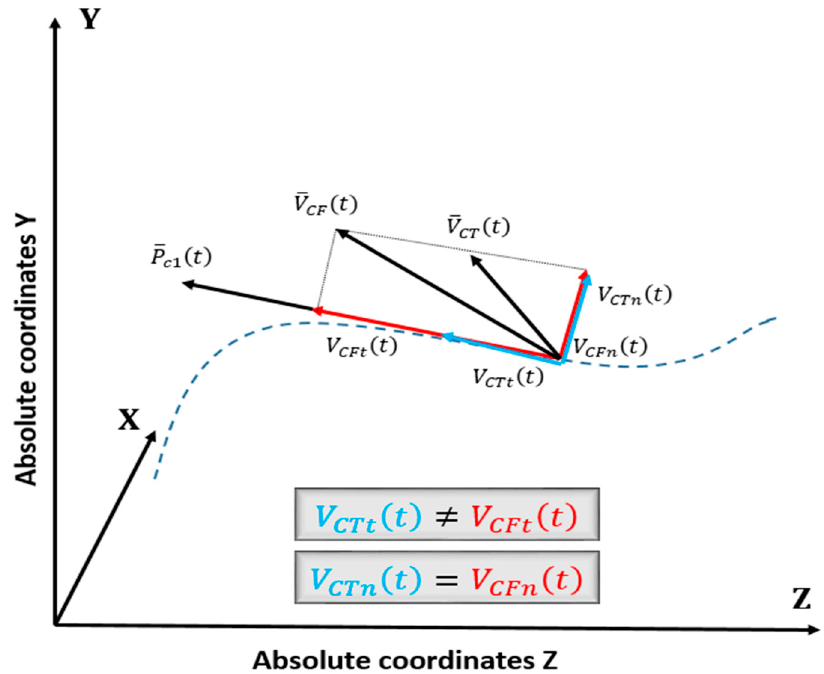
Figure 4. The motions of the tibia and femur at the contact point.